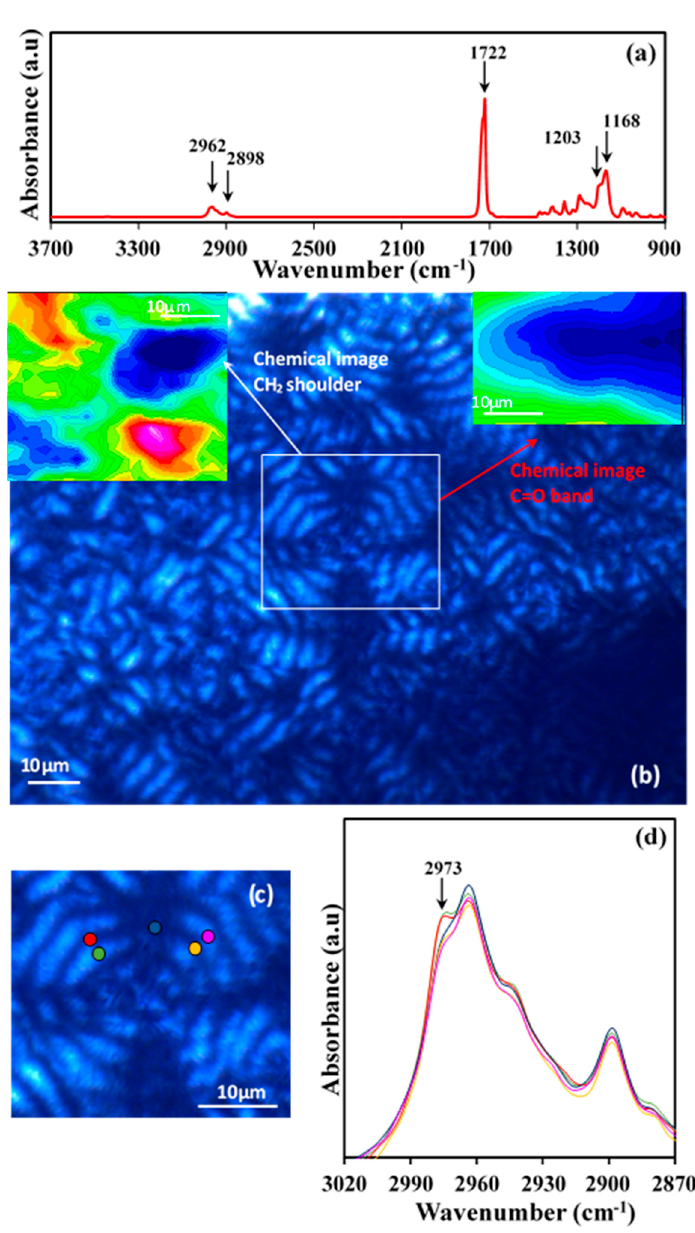
Figure 14. ( a ) FTIR spectra of THE P4HB suture with labelling of main bands; ( b ) Optical polarized micrographs showing spherulites developed in a solvent casting film. Insets show the chemical image obtained from C=O and CH 2 (shoulder) bands; ( c ) Micrographs showing a representative banded spherulite and the specific microdomains were FTIR spectra were recorded; ( d ) Microinfrared spectra taken from the indicated microdomains (keeping the colour code). Different magnifications and wavenumber regions are showed.